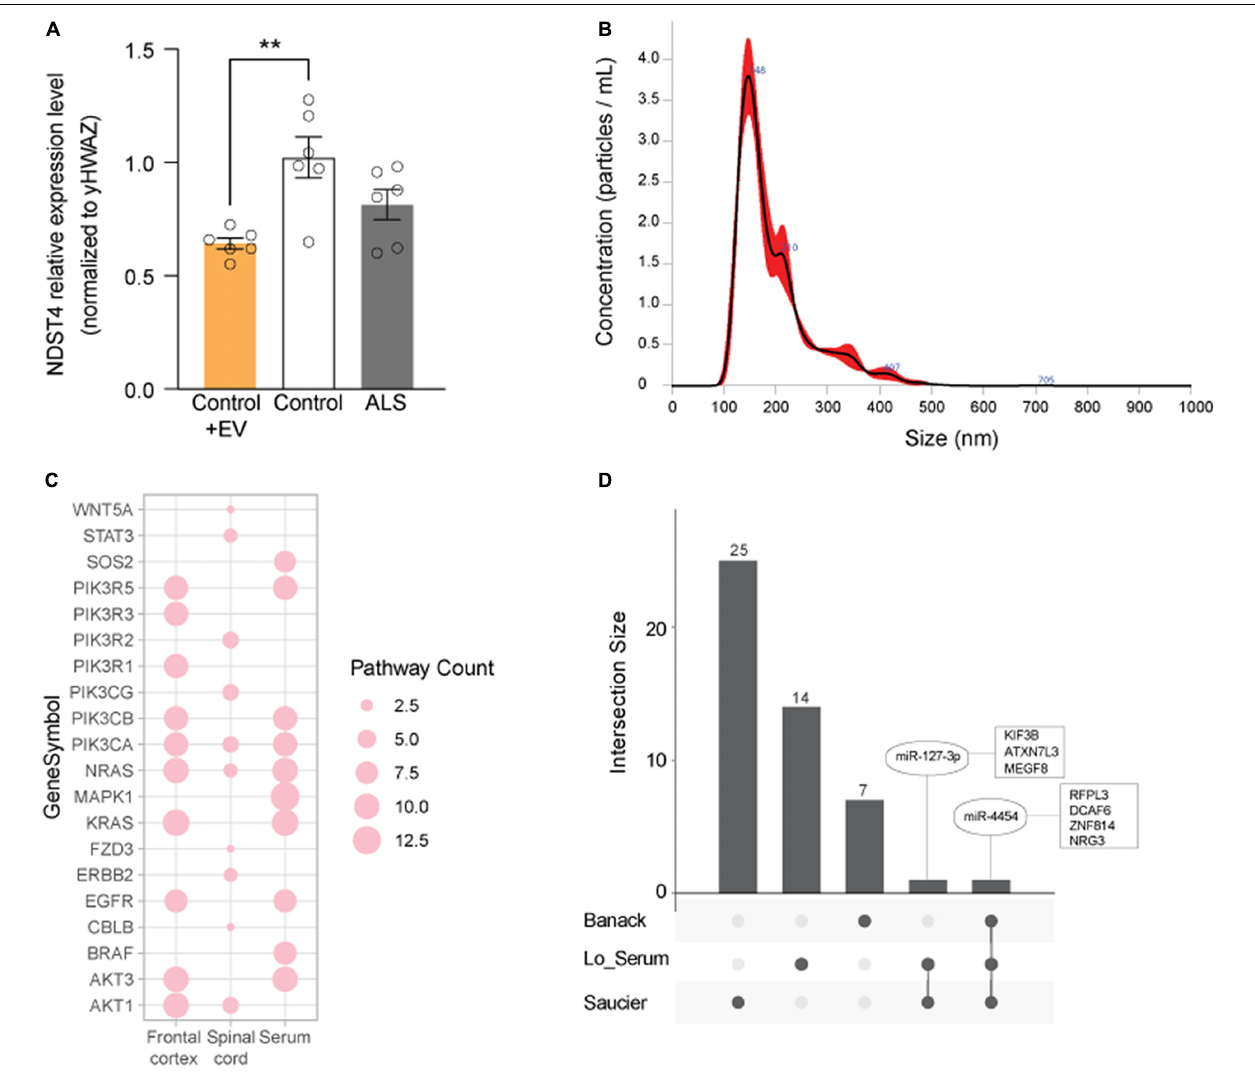
FIGURE 5 | Evaluation of predicted gene targets associated with EV DEmiRNAs. (A) Top 10 genes represented among pathways associated with the DEmiRNAs from frontal cortex (FC), spinal cord (SC), and serum. Node size represents the number of associated pathways containing that gene target (see Supplementary Tables 3–5 ). (B) qPCR for NDST4 in ALS and control iNeurons (one cell line per condition), or in control iNeurons incubated with ALS spinal cord EVs. Results are normalized to an internal reference (YWHAZ) and presented as fold change calculated by the 2 − (cid:49)(cid:49) CT method. Data represent mean ± standard error of the mean from 6 independent experiments. **P < 0.01 compared to the control group. (C) Size distribution of ALS spinal cord EV particles used in (B) determined by NanoSight. (D) EV DEmiRNAs overlapping across published studies (see Table 3 ), where common DEmiRNAs are indicated in ovals, and predicted or verified targets are indicated in squares. Dark gray circles correspond to EV DEmiRNAs unique to each data set; connections between circles correspond to DEmiRNAs overlapping across two or more data